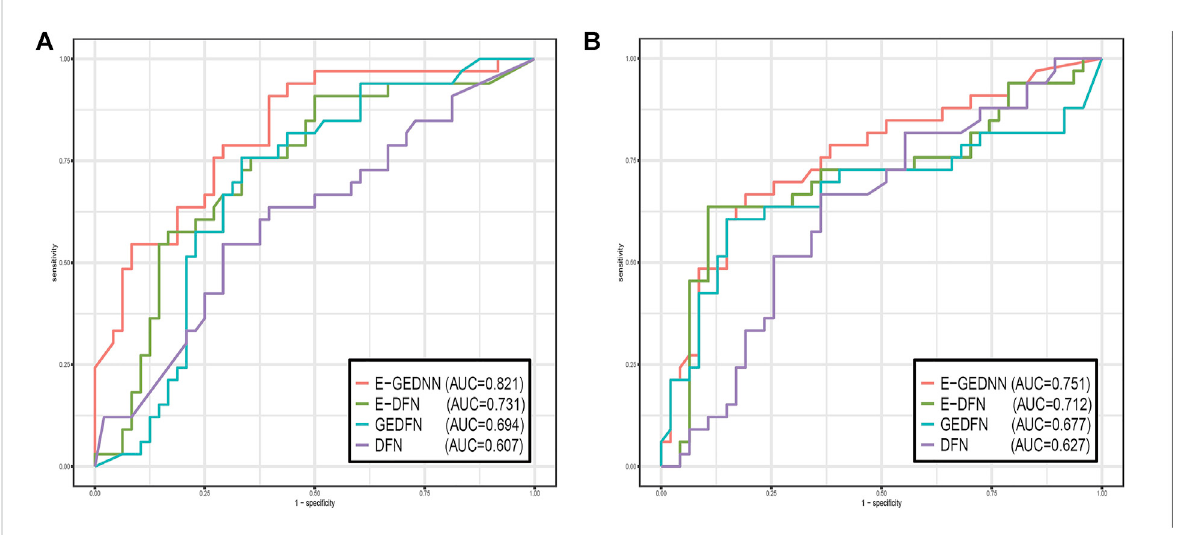
FIGURE 2 Comparison oftheperformanceofG-EDNNwithDNN,E-DNN,GEDFN,andothermethodsusingreceiveroperatingcharacteristicscurves. (A) shows the results for GSE28127, and (B) shows the results for GSE95496. The legend contains the AUC values of each method on the data sets. Our method has the highest AUC value, indicating that our method outperforms the other